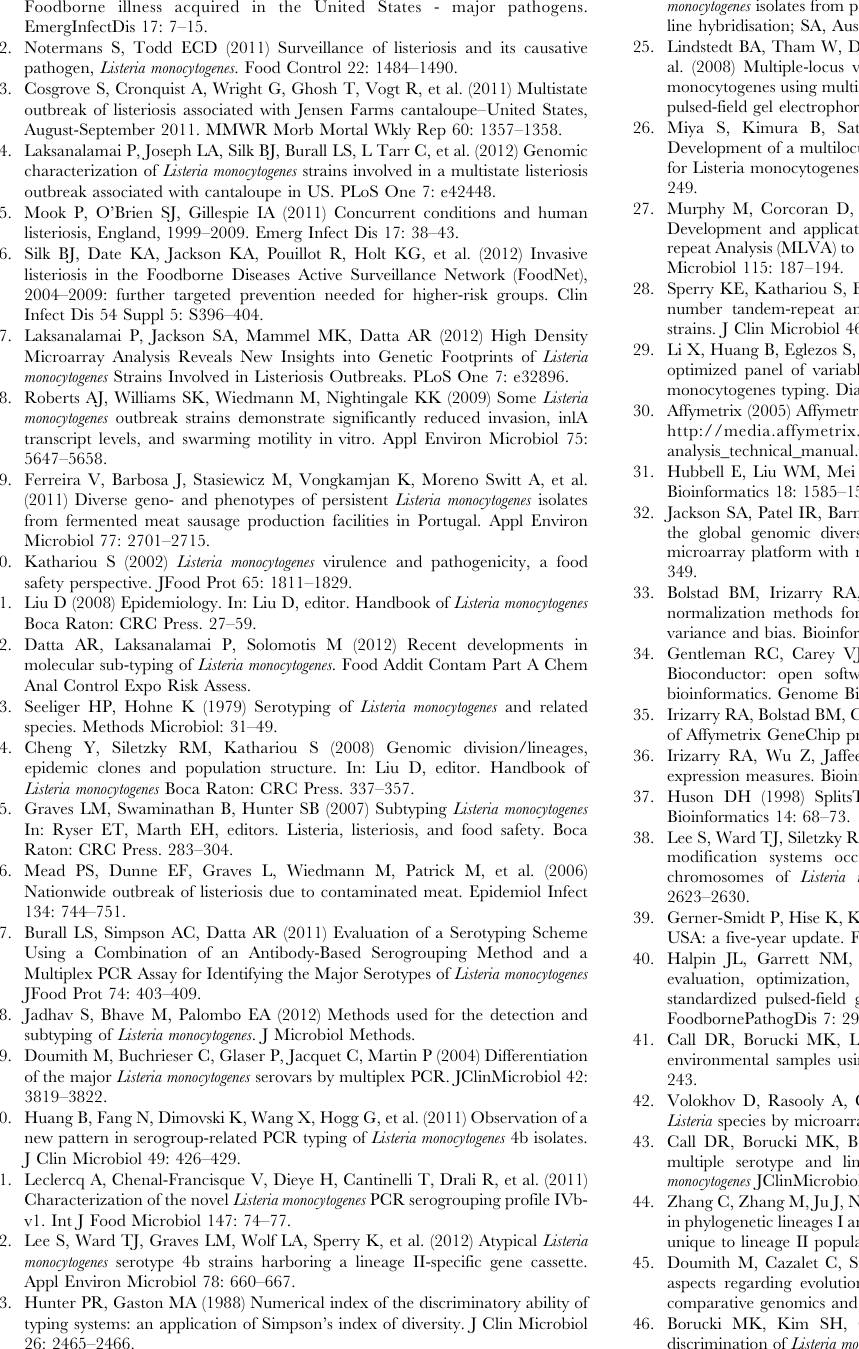
Table S2 Probe-sets uniquely present in LS643, LS644 and LS645 but absent in